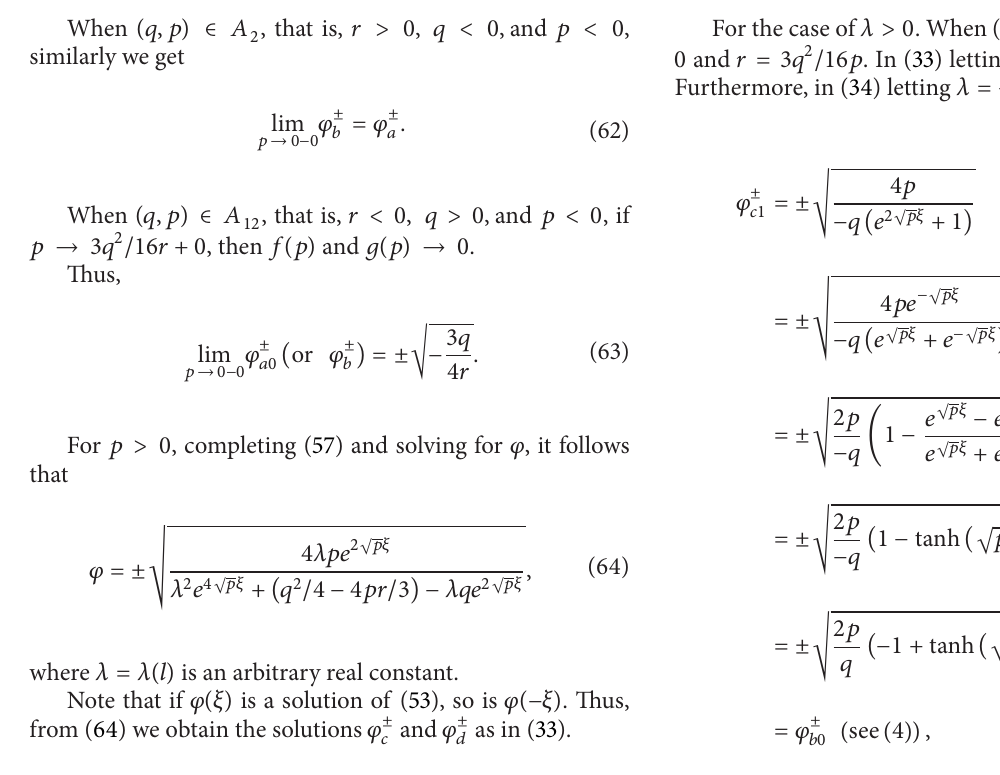
Figure 8: (The four 2-blow-up waves become four 1-blow-up waves.) The varying process for the figures of 𝜑 ± 𝑐 and 𝜑 ± 𝑑 when (𝑞, 𝑝) ∈ 𝐴 3 , 𝜆 < 0, 𝜆 ̸= − √𝜆 /12 , and 𝑝 → 3𝑞 2 /16𝑟 − 0 , where 𝑟 = 1 , 𝑞 = −4, 𝜆 = −4, and 𝑙 0 𝑝 = 3 − 10 −6 , and (d) 𝑝 = 3 − 10 −9